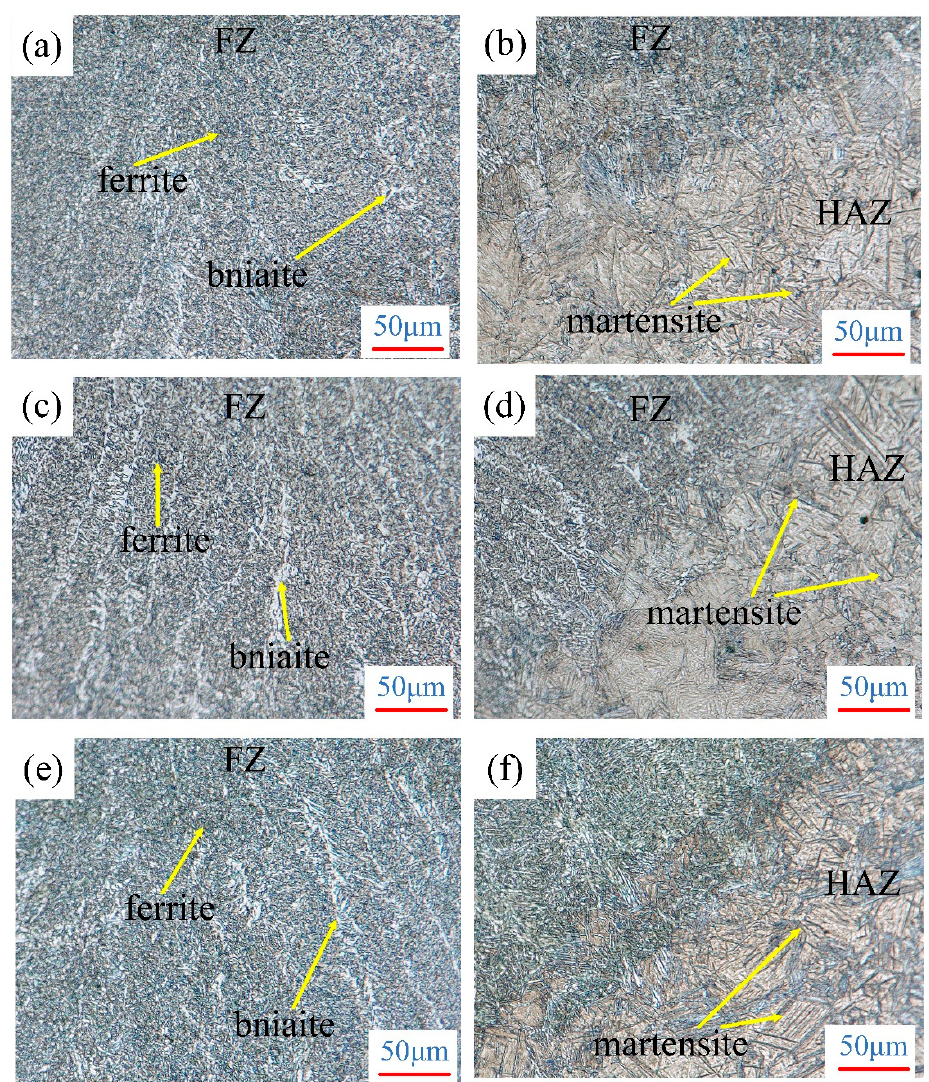
Figure 18. Microstructure of different laser powers: ( a ) 7 kW, D1 point; ( b ) 7 kW, D2 point; ( c ) 7.5 kW, D1 point; ( d ) 7.5 kW, D2 point; ( e ) 8 kW, D1 point; ( f ) 8 kW, D2 point.